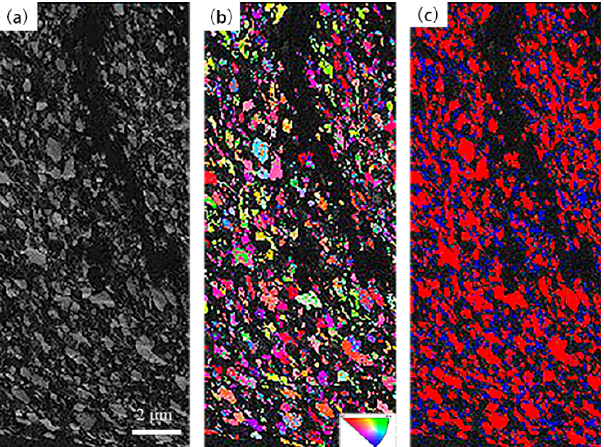
Figure 8. EBSD images of TBC YSZ-2 after heat treatment at 1550 °C/100 h: ( a ) quality maps; ( b ) orientation maps; ( c ) phase maps; The orientations are defined by tetragonal lattice symmetry.